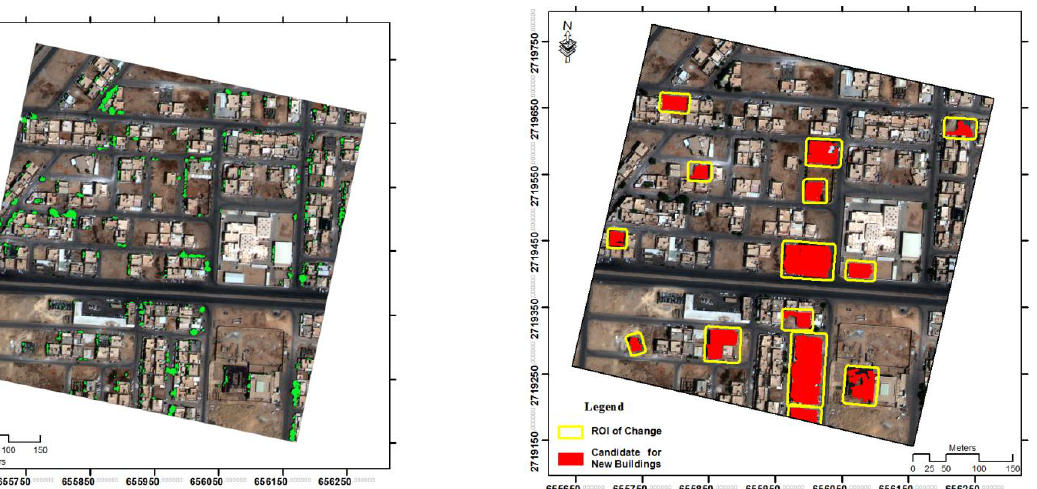
3D edge matching is able to delineate building outlines.